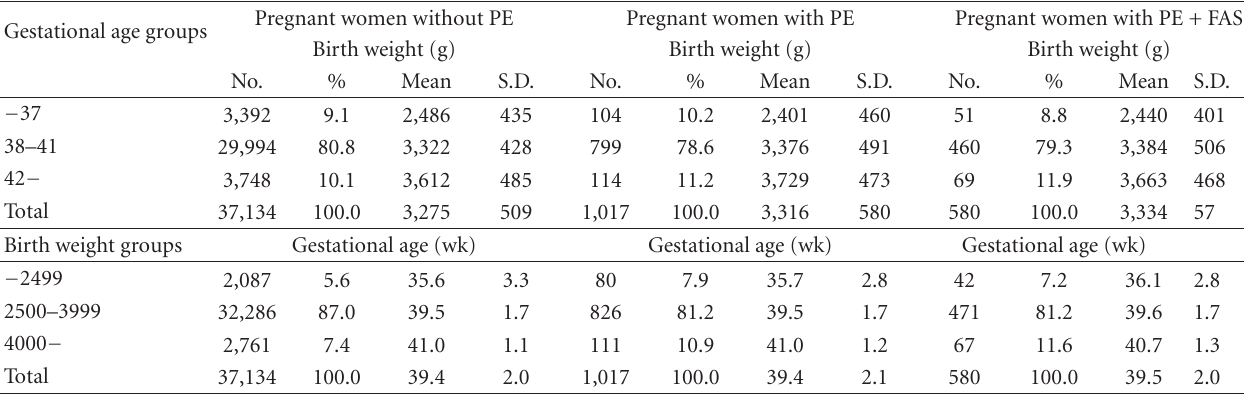
Table 3: Distribution of gestational age (preterm, term, postterm) and birth weight (low, average, large) groups in pregnant women without PE (as reference) and with PE, in addition in pregnant women with PE with folic acid supplementation.